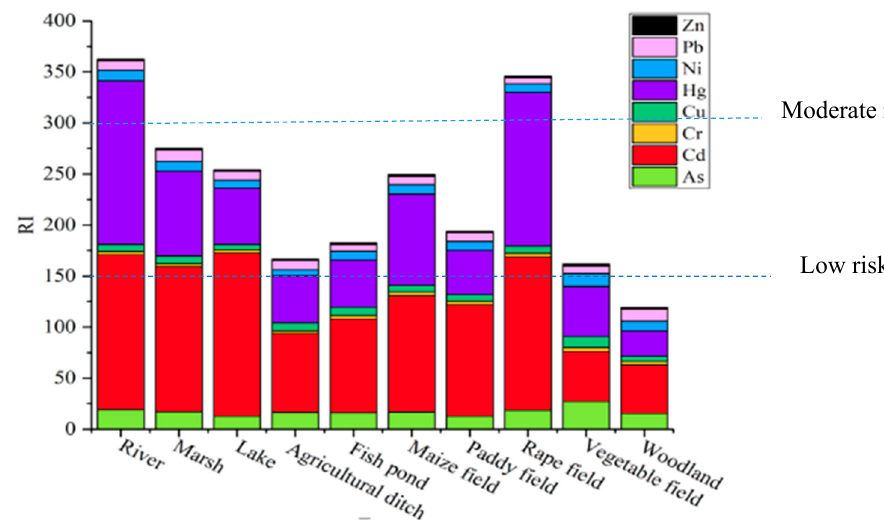
Figure 5. Ecological risk indices ( RI ) in different landuse types of the Huixian wetland.